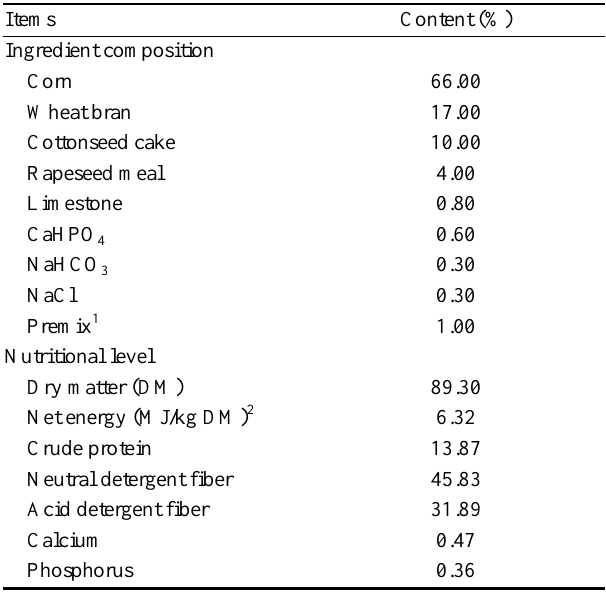
Table 1. Composition and nutrient levels of the basal